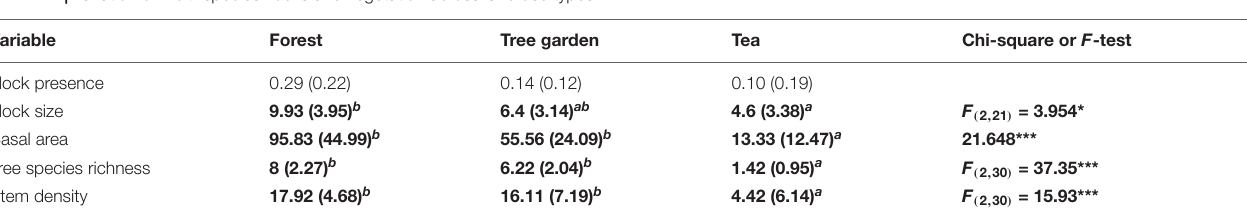
Values are shaded gray in the land use where they are highest. Standard deviation follows in parenthesis. Variables are bolded where their variation is significant by ANOVA with Tukey post hoc test or Kruskal-Wallis test with Bonferroni correction. Letters indicate differences in Tukey post hoc tests (p < 0.05) and Kruskal-Wallis tests with Bonferroni correction a > b > c. *p < 0.05; ***p <